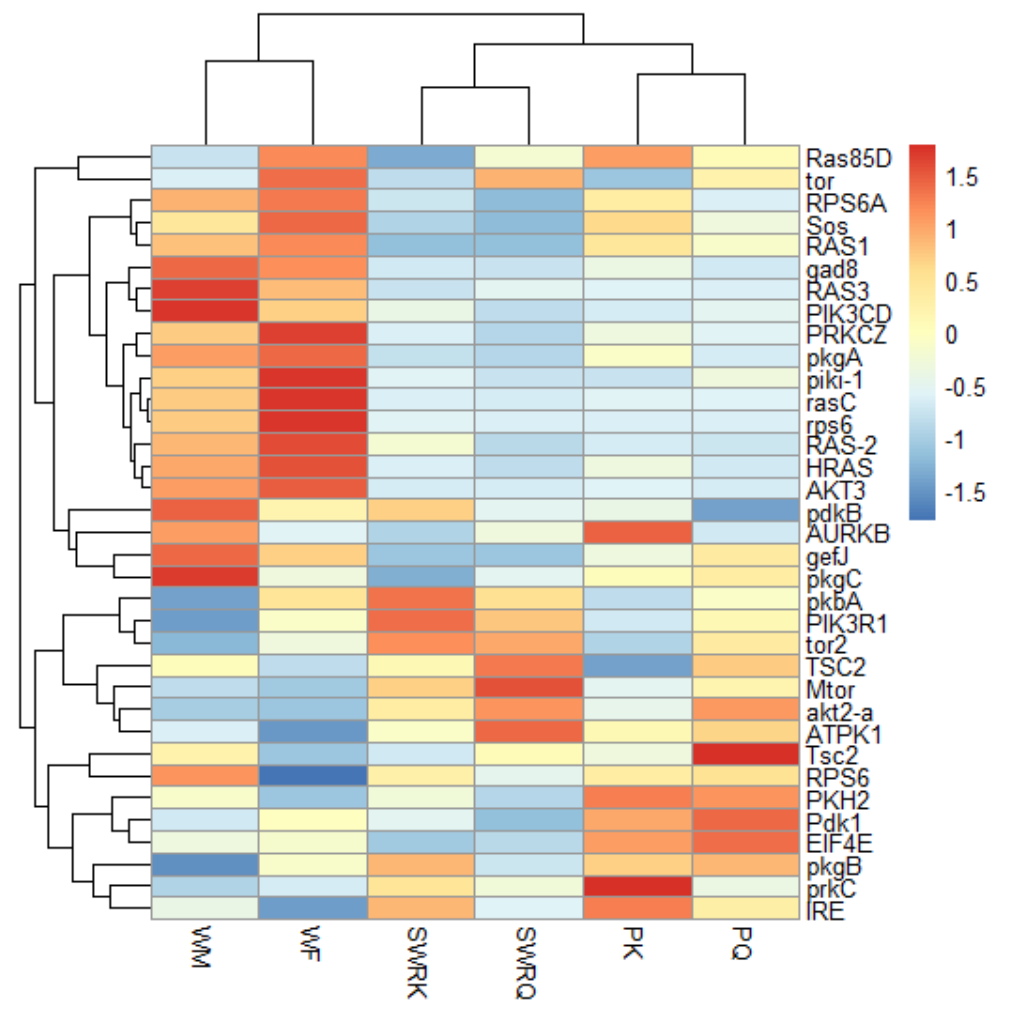
Figure 5. The heat map indicates the differentially expressed gene (DEGs) involved in the insulin signaling pathway in different castes of R. chinensis . The castes are SWRK, SWRQ, PQ, PK, WM, and WF. A change in color from red to blue indicates the gene expression level.